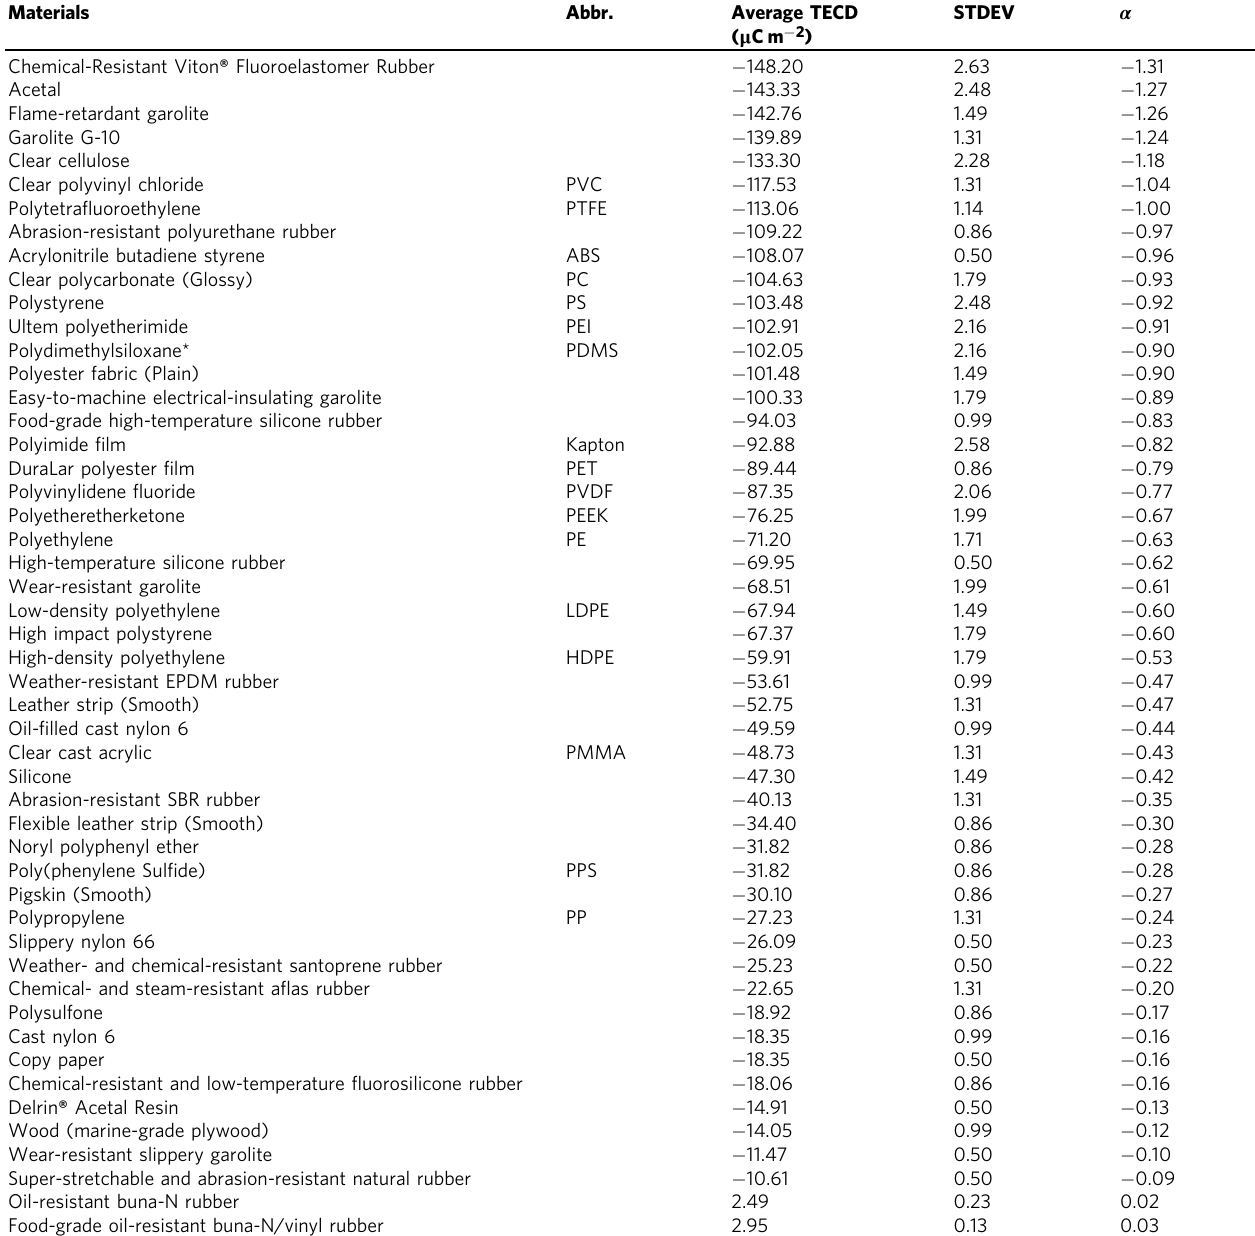
Table 1 Triboelectric series of materials and their triboelectric charge density (TECD)